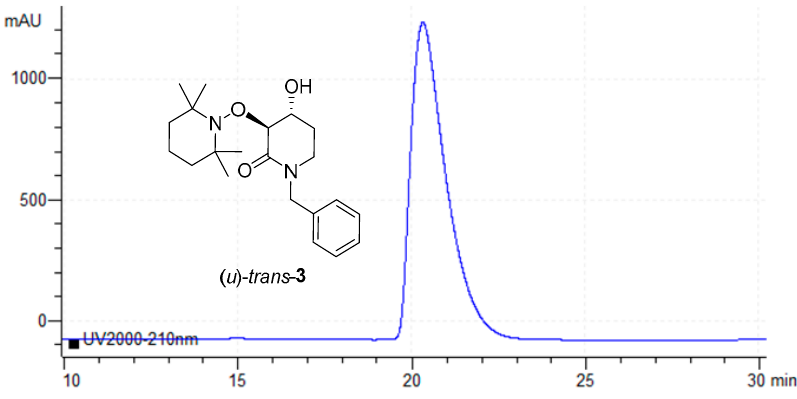
Figure 5. Chiral-HPLC de-acylation product ( u )- trans - 3 .